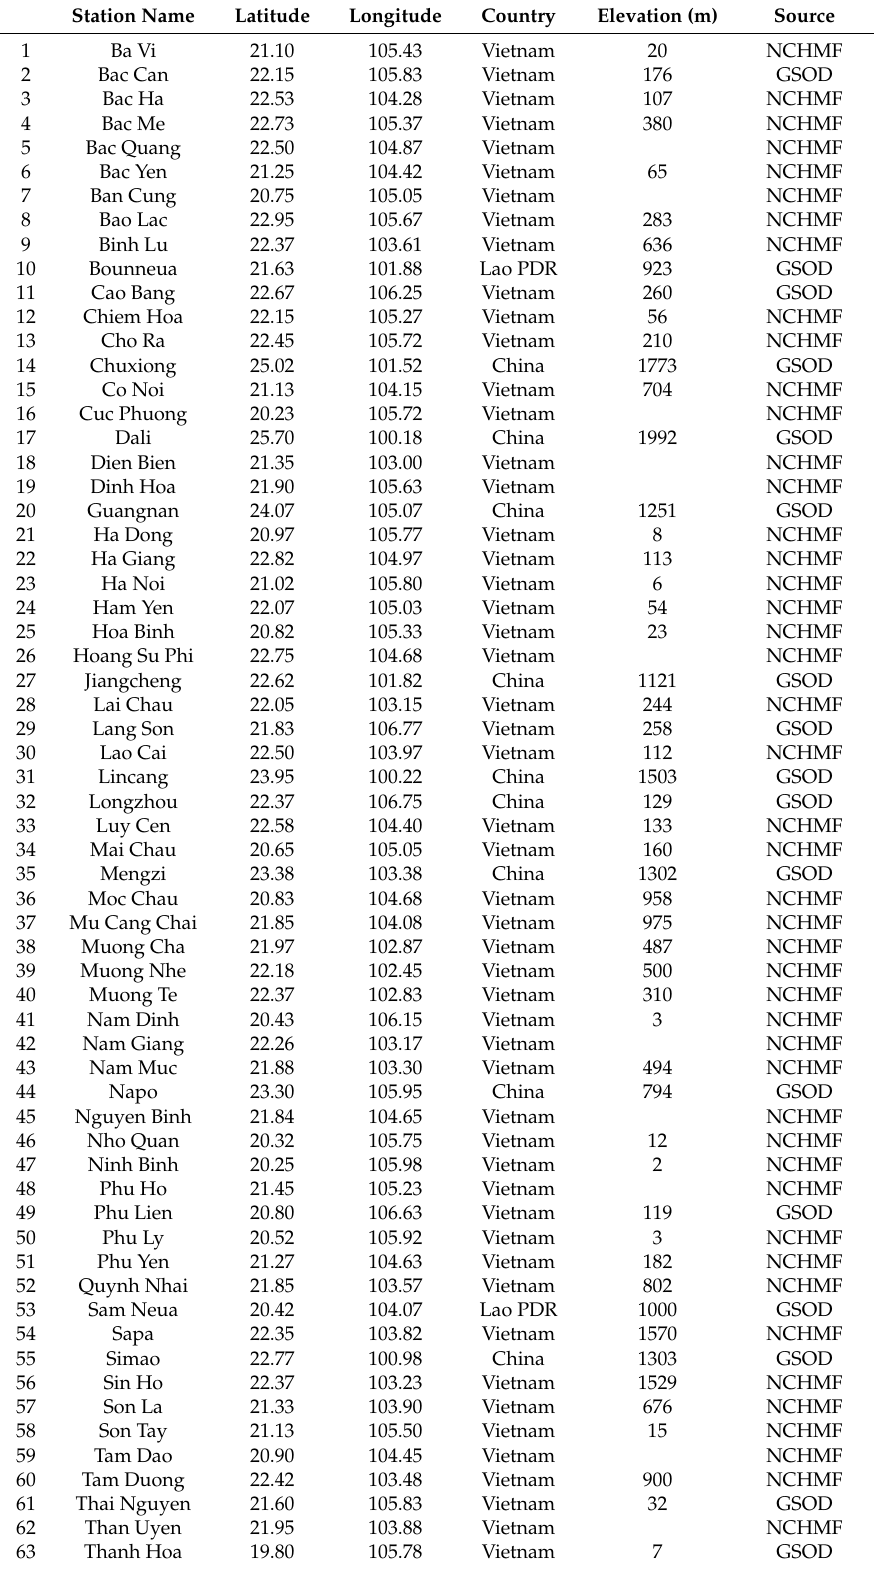
Table A1. Metadata of rainfall